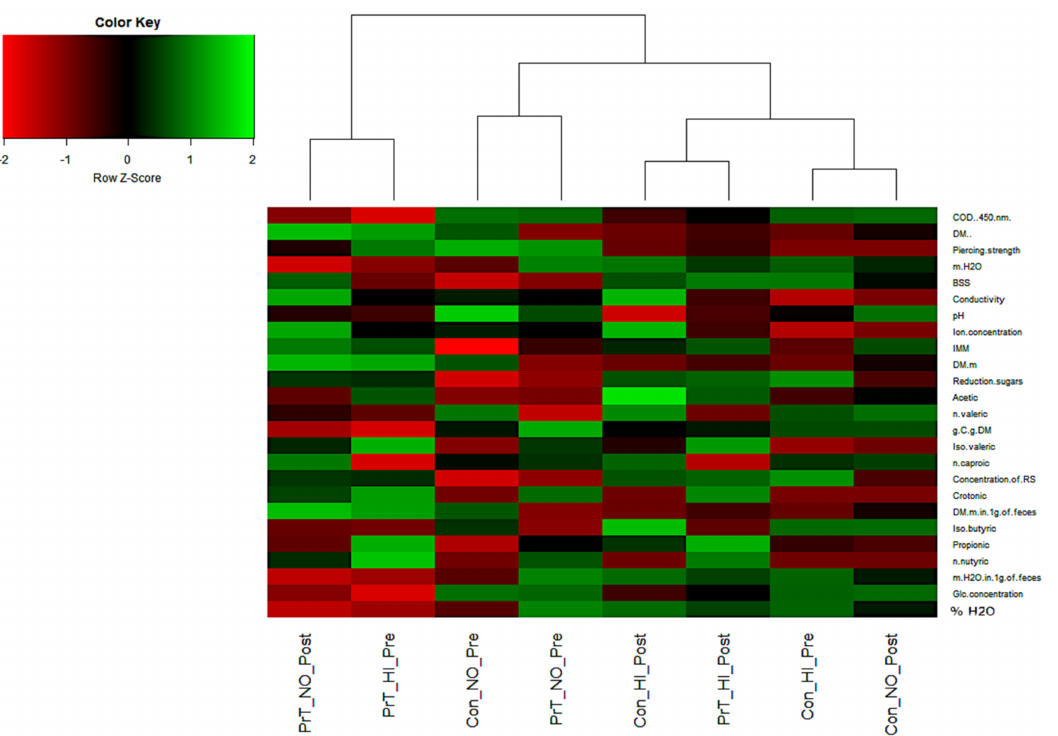
Figure 1. A heatmap summarizing the differences in the 25 measured parameters (COD—chemical oxygen demand, DM—dry matter, m—mass (g), BSS—Bristol stool scale, IMM—molecular mass index, C—carbon, RS—reduction sugars, Glc—glucose) describing the intestinal environment of the preterm and full-term groups exposed to distinct training regimes of the PreTerm project (Figures S1–S3). No significant difference was observed (PERMANOVA; p > 0.05; n permutations =